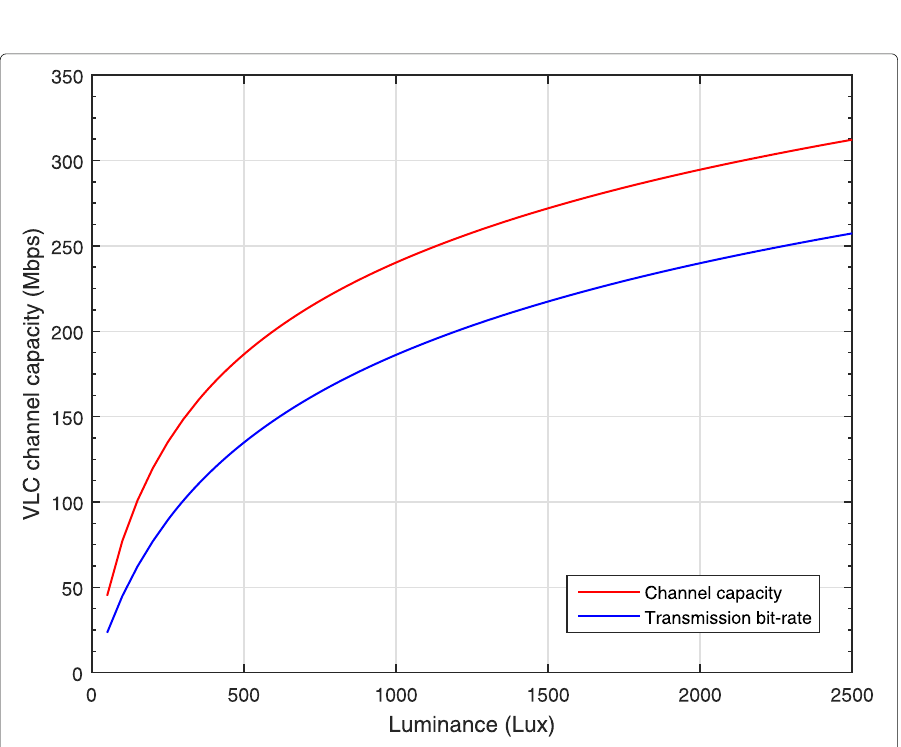
Fig. 11 Relationship between channel capacity and